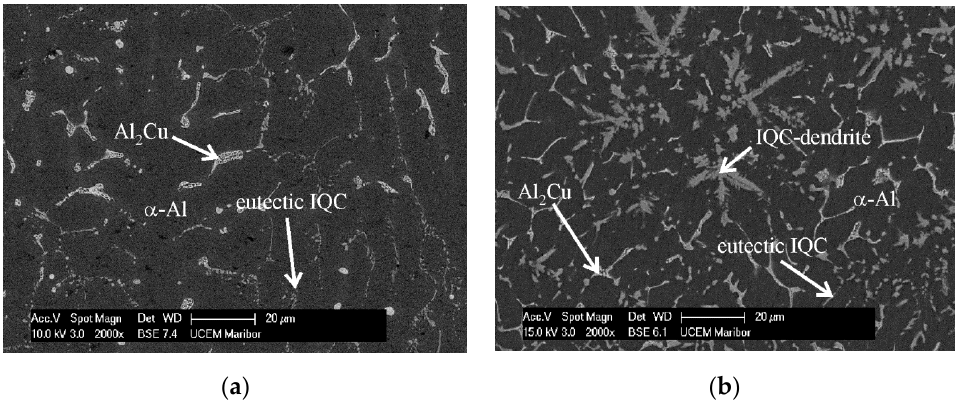
Figure 1. Backscattered electron micrographs of the gravitationally cast samples in the as-cast conditions of ( a ) the alloy Al 96.5 Mn 0.8 Cu 1.2 Be 1.5 , ( b ) Al 95.4 Mn 1.8 Cu 1.6 Be 1.2 . Polished